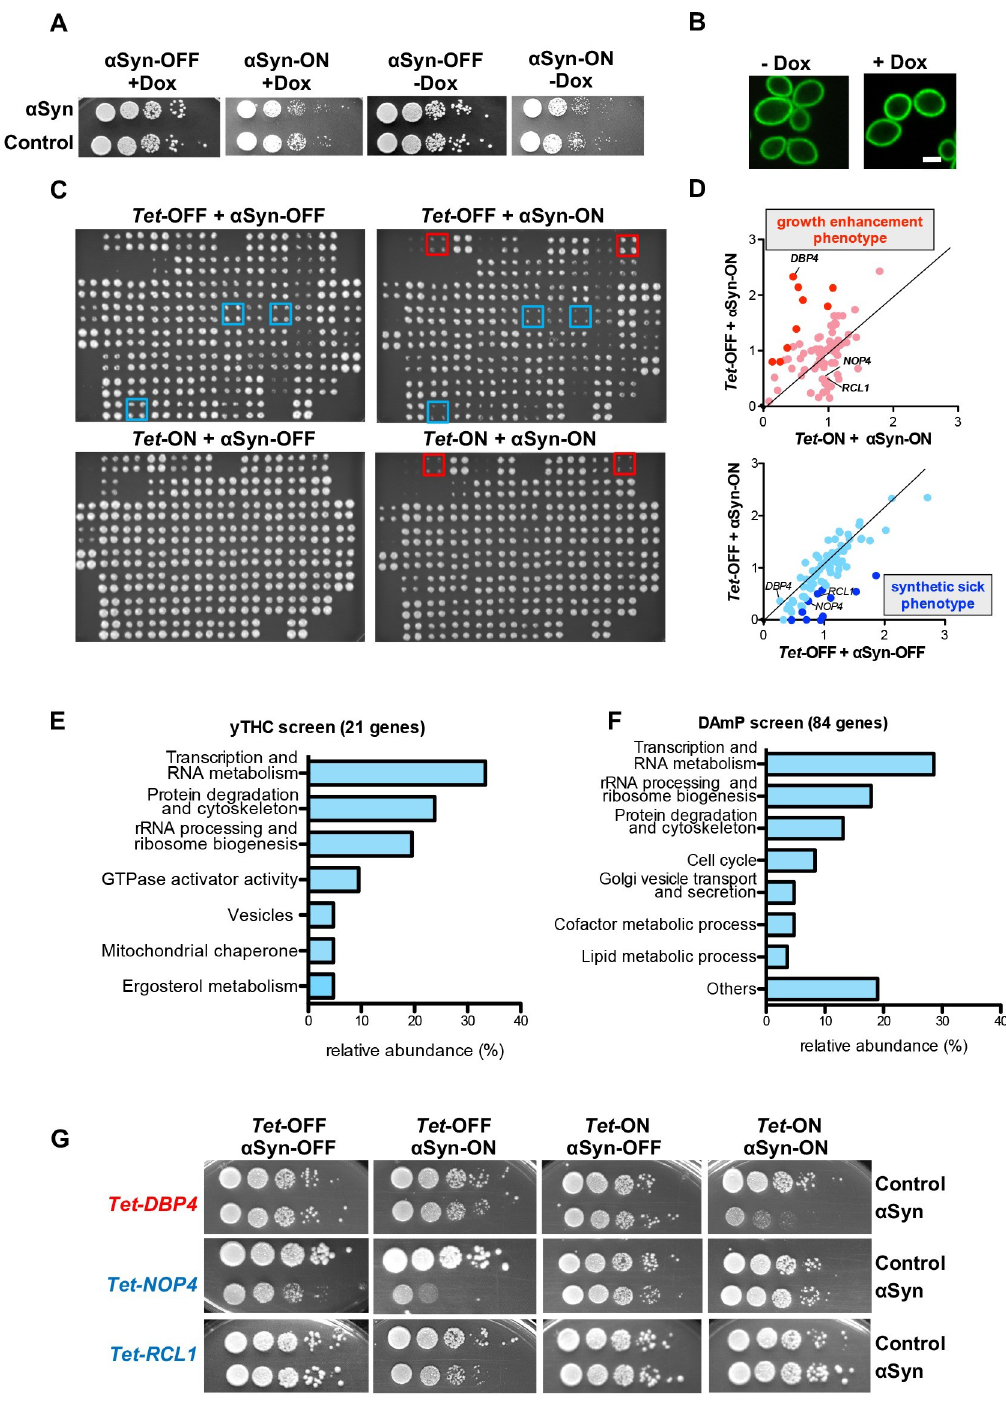
Fig 1. Yeast essential gene screens for modulators of α Syn toxicity. (A) Growth assays of yeast cells expressing GAL1 -driven α Syn-GFP from two genomically integrated copies in Y7092 background, used as query strain in the Tet -Promoters Hughes collection (yTHC) and decreased abundance by mRNA perturbation (DAmP) collection screens, with empty vector as control. Cells were spotted in 10-fold dilutions on selective plates containing glucose ( α Syn-OFF) or galactose ( α Syn-ON), in presence (+) or absence (-) of 10 μ g/ml doxycycline (Dox) that represses the Tet -promoter. (B) Fluorescence microscopy of the query strain after 6 h induction of α Syn-GFP expression in presence or absence of Dox. Scale bar = 2 μ m. (C) Scoring of putative genetic interactions with essential genes from yTHC library. Example of growth phenotypes assayed in quadruplicate on selection plates with glucose ( Tet -ON + α Syn-OFF), glucose + doxycycline ( Tet -OFF + α Syn-OFF), galactose ( Tet -ON + α